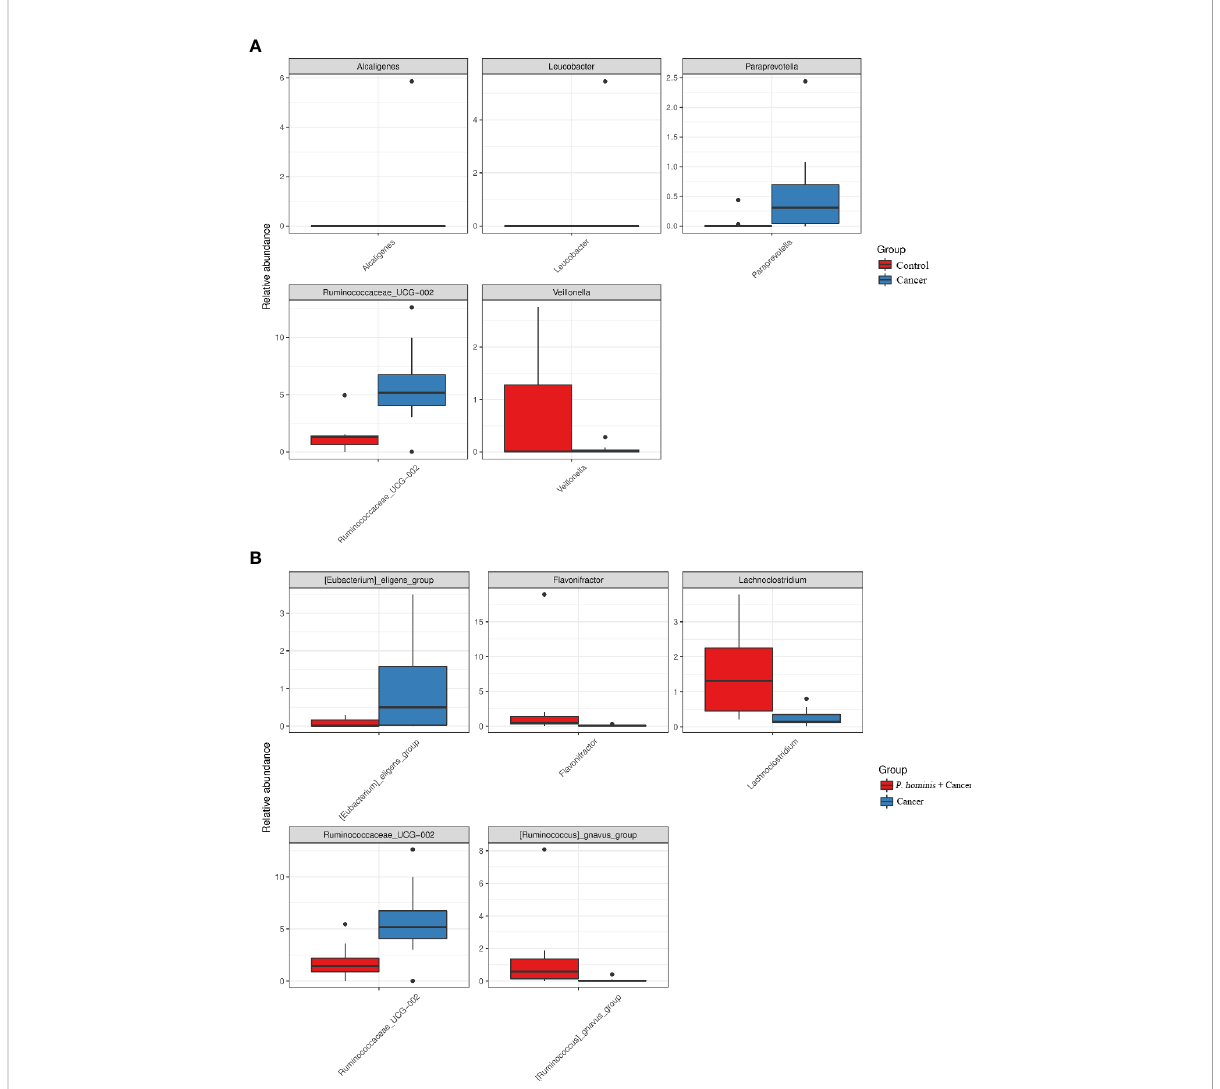
FIGURE 5 Comparison of the relative abundance of bacterial genera among the Control, Cancer, and P. hominis+ cancer groups. (A) Comparison of the relative abundance of bacterial genera between the Control and Cancer groups. (B) Comparison of the relative abundance of bacterial genera between the Cancer and P. hominis+ cancer